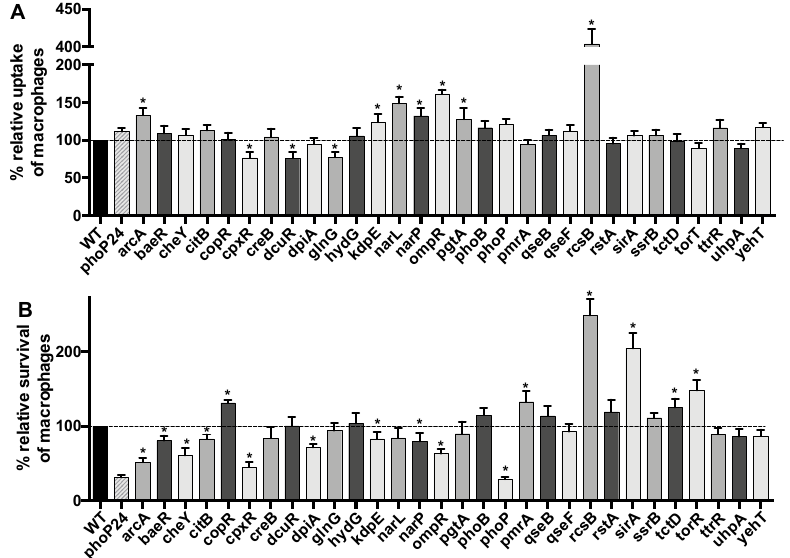
Figure 2. Effect of loss of TCS response regulators during interaction with human macrophages. THP-1 cells were differentiated into macrophages and infected with S . Typhi wild-type strain and the isogenic RR mutants. The level of bacterial uptake (phagocytosis) ( A ) and the level of survival after 18 h infection ( B ) were determined. All assays were conducted in duplicate and repeated independently at least three times. The results are expressed as the mean ± SEM of replicate experiments. Significant differences (* p < 0.0001) as compared to wild-type were determined by the Student’s unpaired t -test. The dashed line corresponds to the wild-type level.